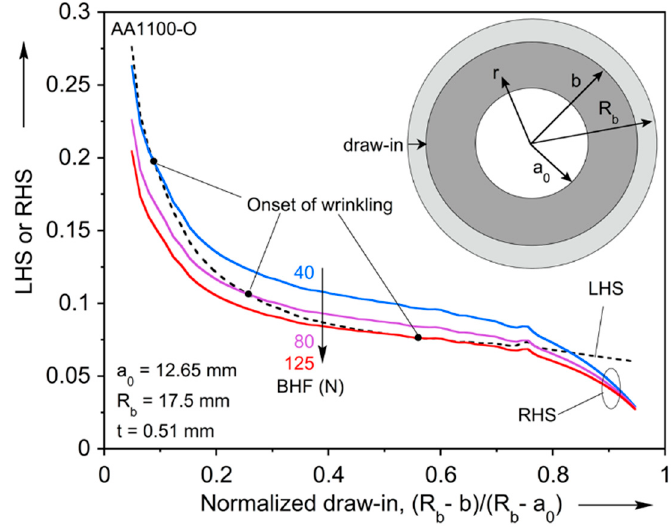
Figure 10. Evolution of the LHS and RHS of Equation (25) with the normalized draw-in during the drawing process, for different BHFs.